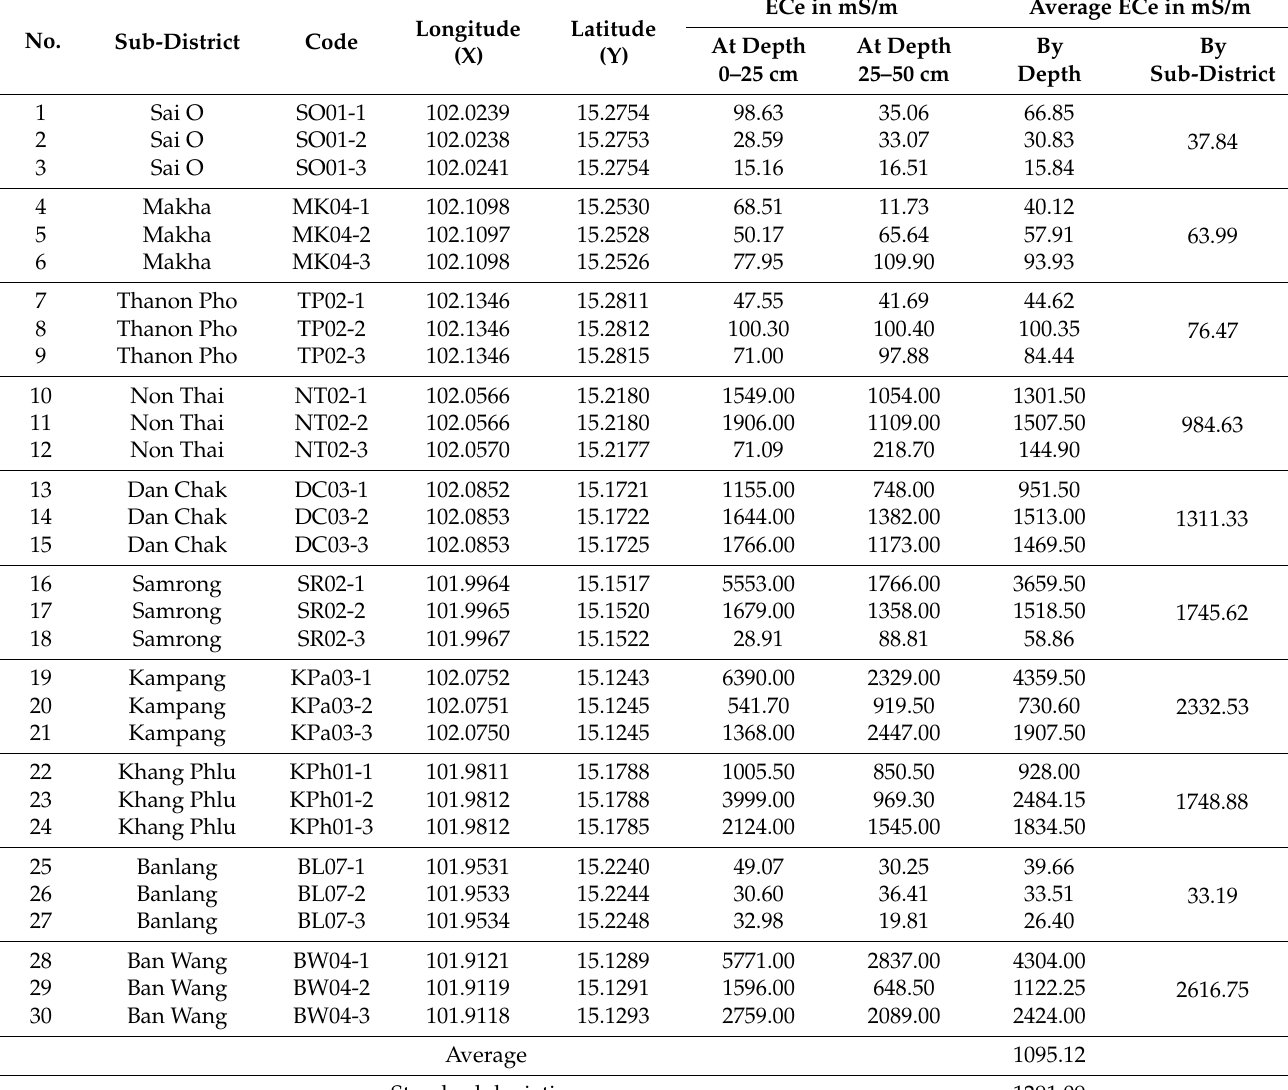
Table 5. The saturated soil paste extraction (ECe) at the exact soil sample collection location.